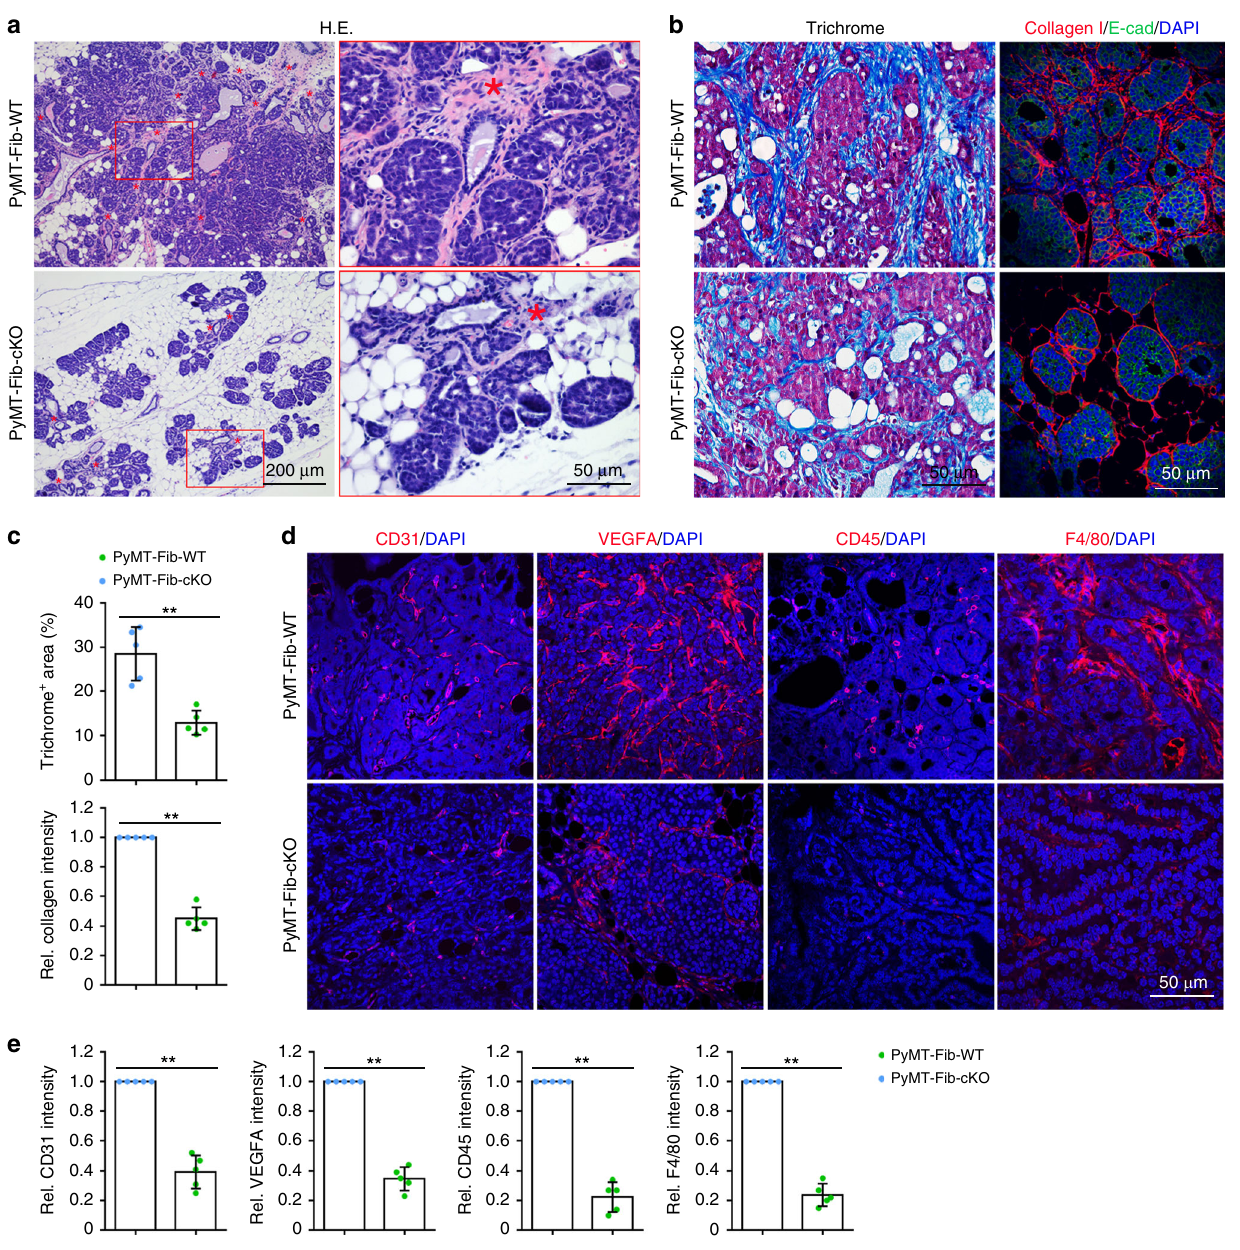
Fig. 3 Loss of ZEB1 in stromal fi broblasts causes impaired ECM deposition and reduced recruitment of immune cells and endothelial cells. a Representative images of haematoxylin and eosin (H&E)-stained primary tumours dissected from PyMT-Fib-WT and -cKO females ( fi ve mice, each). Magni fi ed areas of boxed sections are shown in right panels. Asterisk denotes the tumour stroma. b H&E staining (left) and type I collagen/E-cadherin immuno fl uorescent staining (right) of primary tumours from PyMT-Fib-WT and -cKO females (images are representative of images from fi ve mice). Nuclei are counterstained with DAPI. c Quanti fi cation of relative fl uorescent intensities in ten random fi elds of each section of the indicated primary tumours as shown in b ( n = 5 independent experiments). Two-sided Student ’ s t test. d Immuno fl uorescent staining of CD31, VEGFA, CD45 and F4/80 in primary tumours from PyMT- Fib-WT and -cKO mice (images are representative of images from fi ve mice). Nuclei are counterstained with DAPI. e Quanti fi cation of relative fl uorescent intensities in ten random fi elds of each section of primary tumours as shown in d ( n = 5 independent experiments). Two-sided Student ’ s t test. All data are represented as mean ± s.d. ** P < 0.01. The source data are provided as a Source Data fi